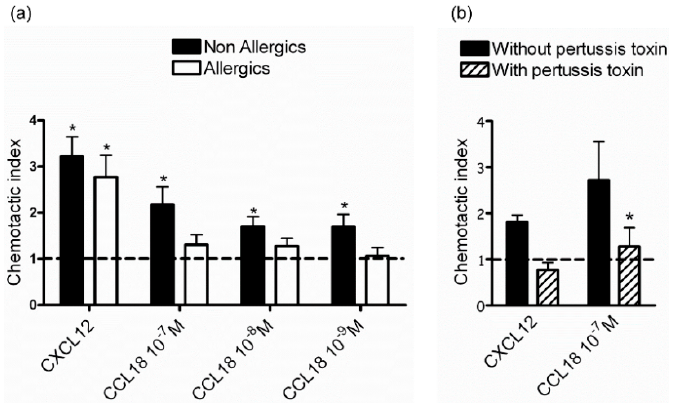
Figure 1. CCL18 attracts Natural Killer (NK) cells from nonallergic donors in a G-protein-dependent manner. ( a ) Migration towards the positive control CXCL12 and different concentrations of CCL18 ( n = 14 for nonallergic donors, n = 5 for allergic donors). The line sets at 1 represent chemotactic index of medium. * p < 0.05 chemokines versus medium. ( b ) NK cells from nonallergic donors were incubated with or without pertussis toxin immediately before chemotaxis assay ( n = 3). To evaluate if CCL18 preferentially attracted a defined subset, NK cells from nonaller- gic donors were stained and analyzed by flow cytometry before and after migration toward